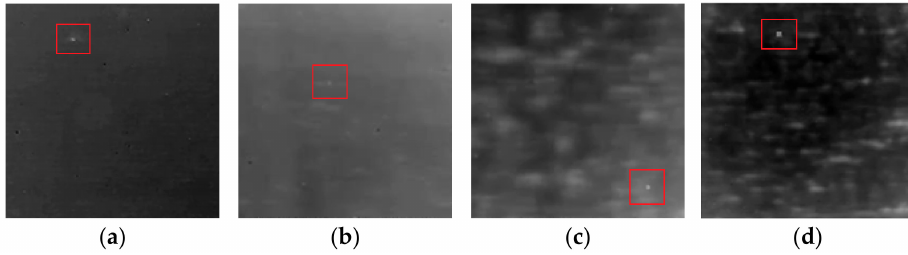
Figure 7. Infrared sea clutter under various undulating conditions. ( a ) Smooth fluctuation. ( b ) Weak fluctuation. ( c ) Moderate fluctuation. ( d ) Strong fluctuation.